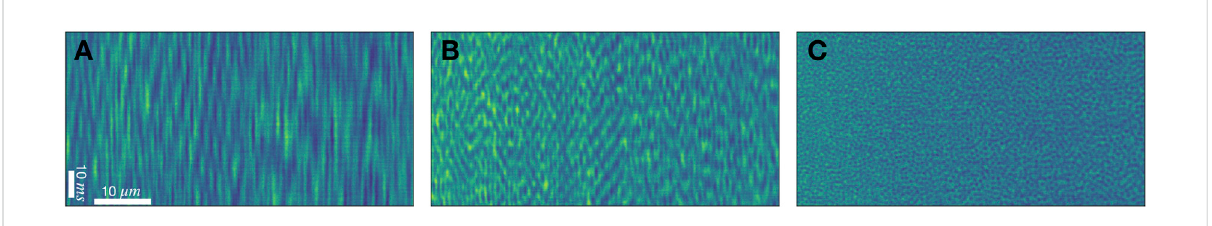
FIGURE 2 Representative space-time kymographs generated from linescans (horizontal) stacked vertically taken in a sheared dense suspension of silica particles of diameter 1 μ m , ϕ = 0.52, at different shear rates. The spheres are not fl uorescent, and a fl uorescent dye is added to the solvent. (A)